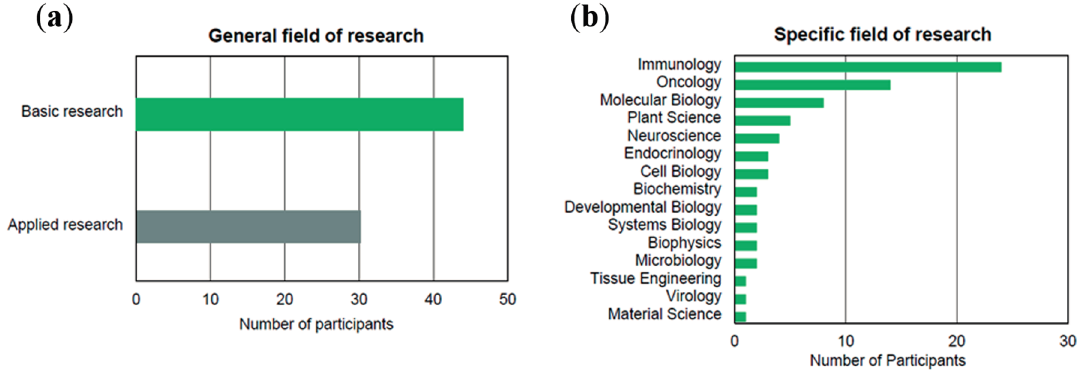
Figure 1. ( a ) Distribution of participants in their general fields of research. 44 participants stated basic research and 30 applied research as their general field; and ( b ) Distribution of participants in their specific fields of research. Immunology and oncology were most frequently